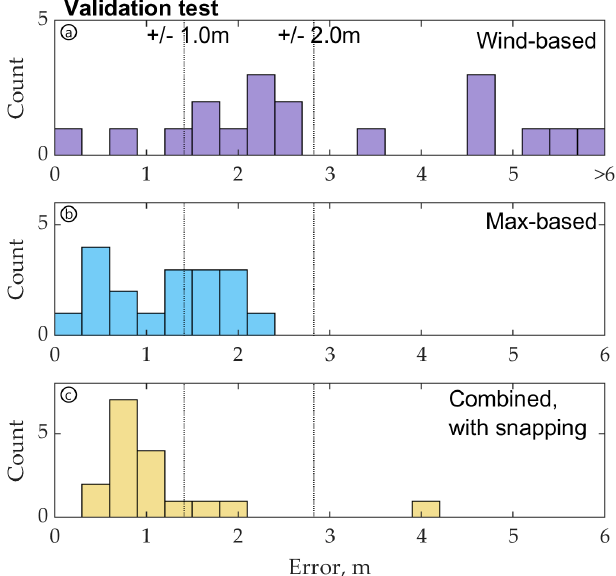
Figure 8. Performance in estimating leak position evaluated at METEC using ( a ) the wind back- projection and ( b ) maximum methane-based methods described in Section 3.1, and ( c ) estimates snapped to the nearest grid cell containing equipment. The combined method was within ±1 m for 14 of 17 cases.